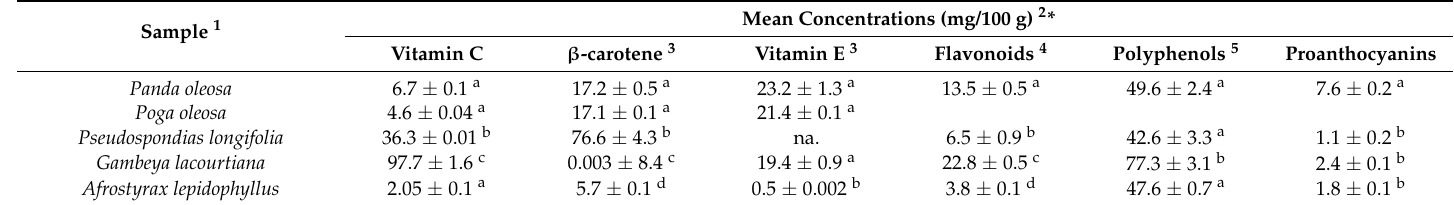
Table 3. Mean concentrations (mg/100 g) edible parts wet basis 1 and standard deviations of bioactive compounds of common forest fruits and nuts consumed in